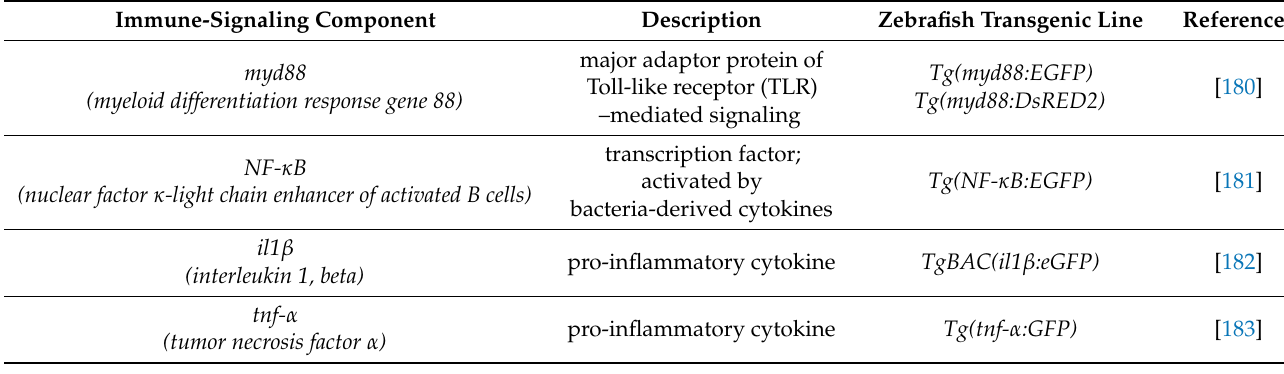
Table 2. Zebrafish transgenic reporter lines to monitor the spatial and temporal activities of immune-signaling components.